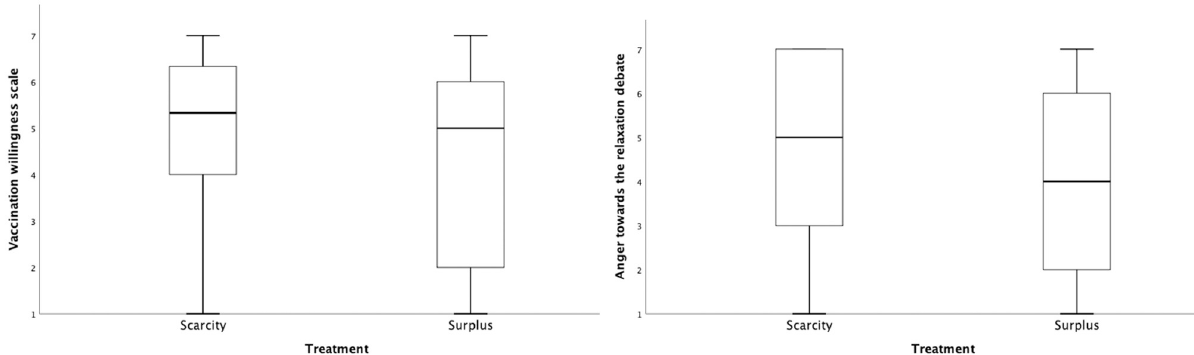
Fig 1. Vaccination willingness and anger towards the relaxation debate as a function of treatment.